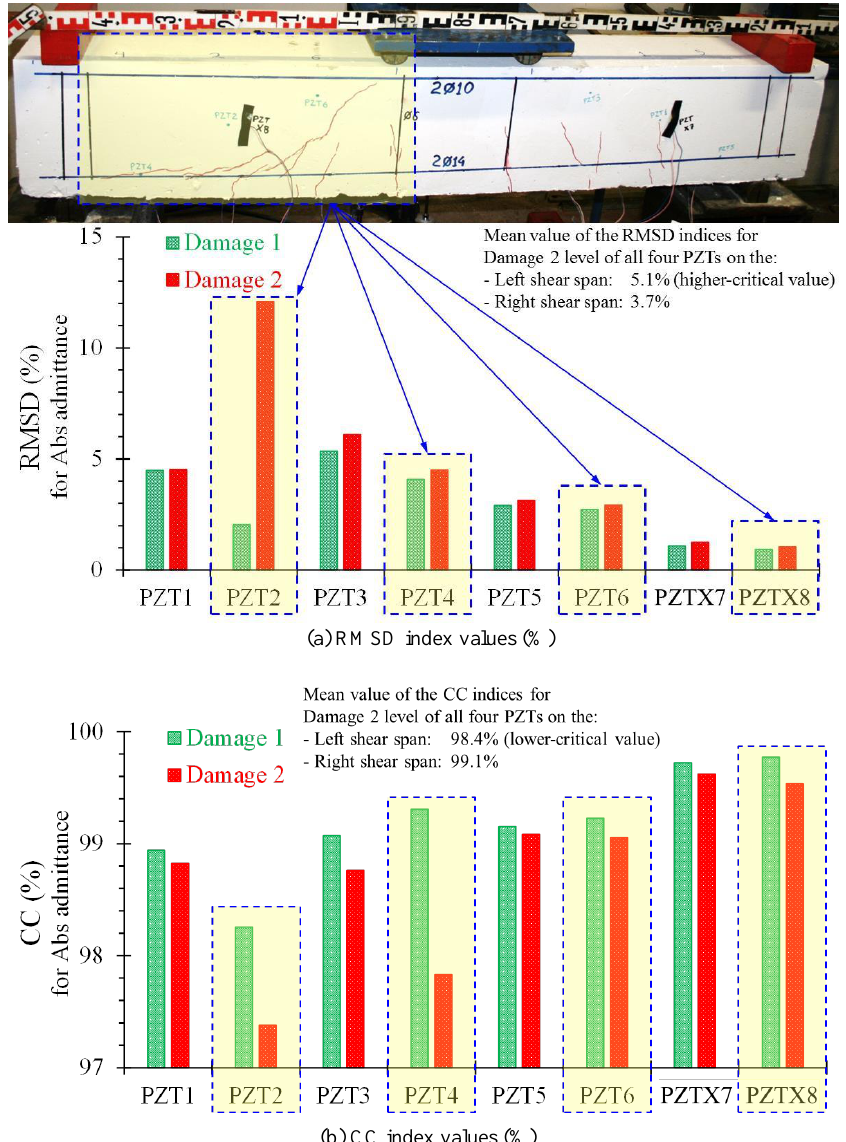
Figure 10. RMSD and CC index values for Abs admittance of each PZT for damage Figure 10: RMSD and CC index values for Abs admittance of each PZT for damage assessment of the two examined damage levels (Damage 1 assessment of the two examined damage levels (Damage 1 and Damage 2) and Damage